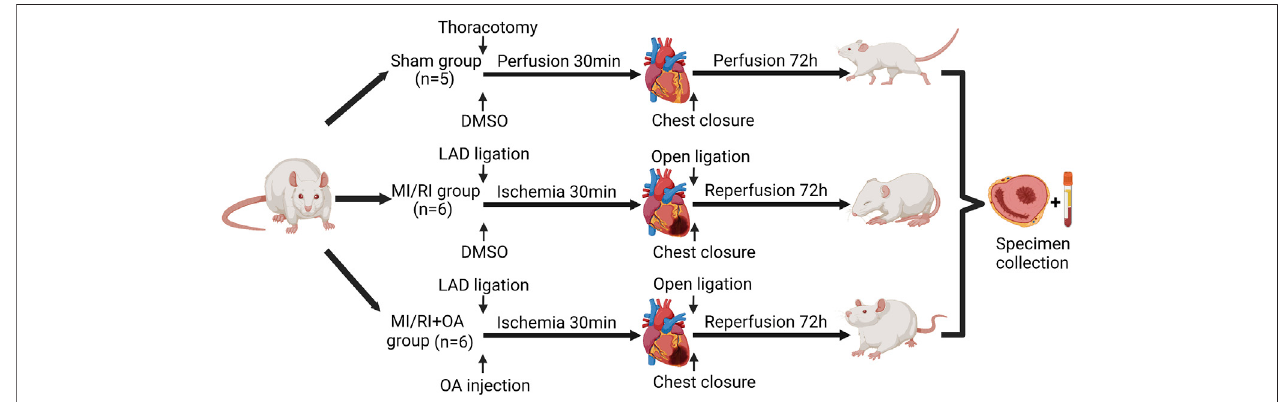
FIGURE 1 | Flow chart of the experimental protocol. We acknowledge the use of Biorender to generate Figure